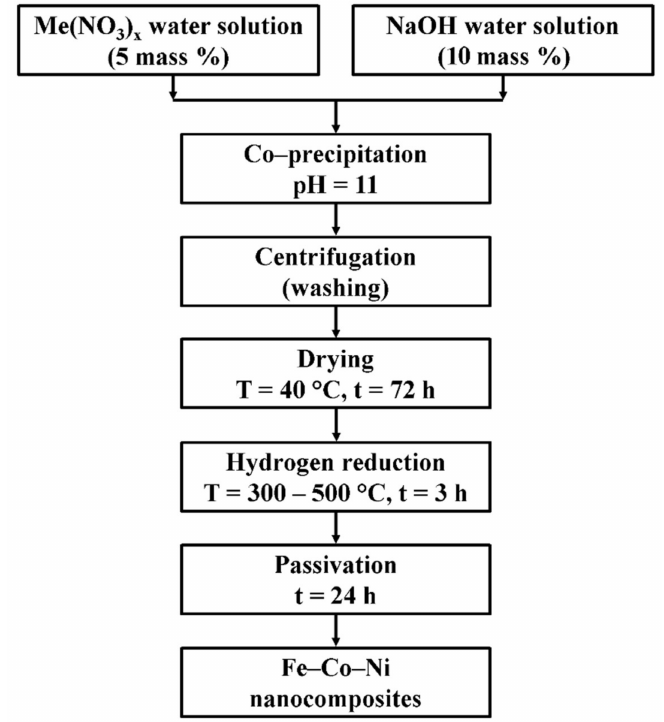
Figure 1. The production scheme of Fe–Co–Ni nanocomposites.